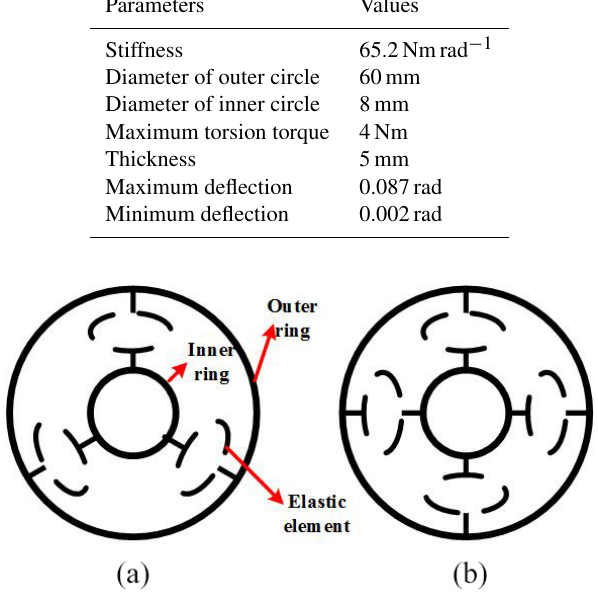
Figure 1. Two kind of topologies of elastic